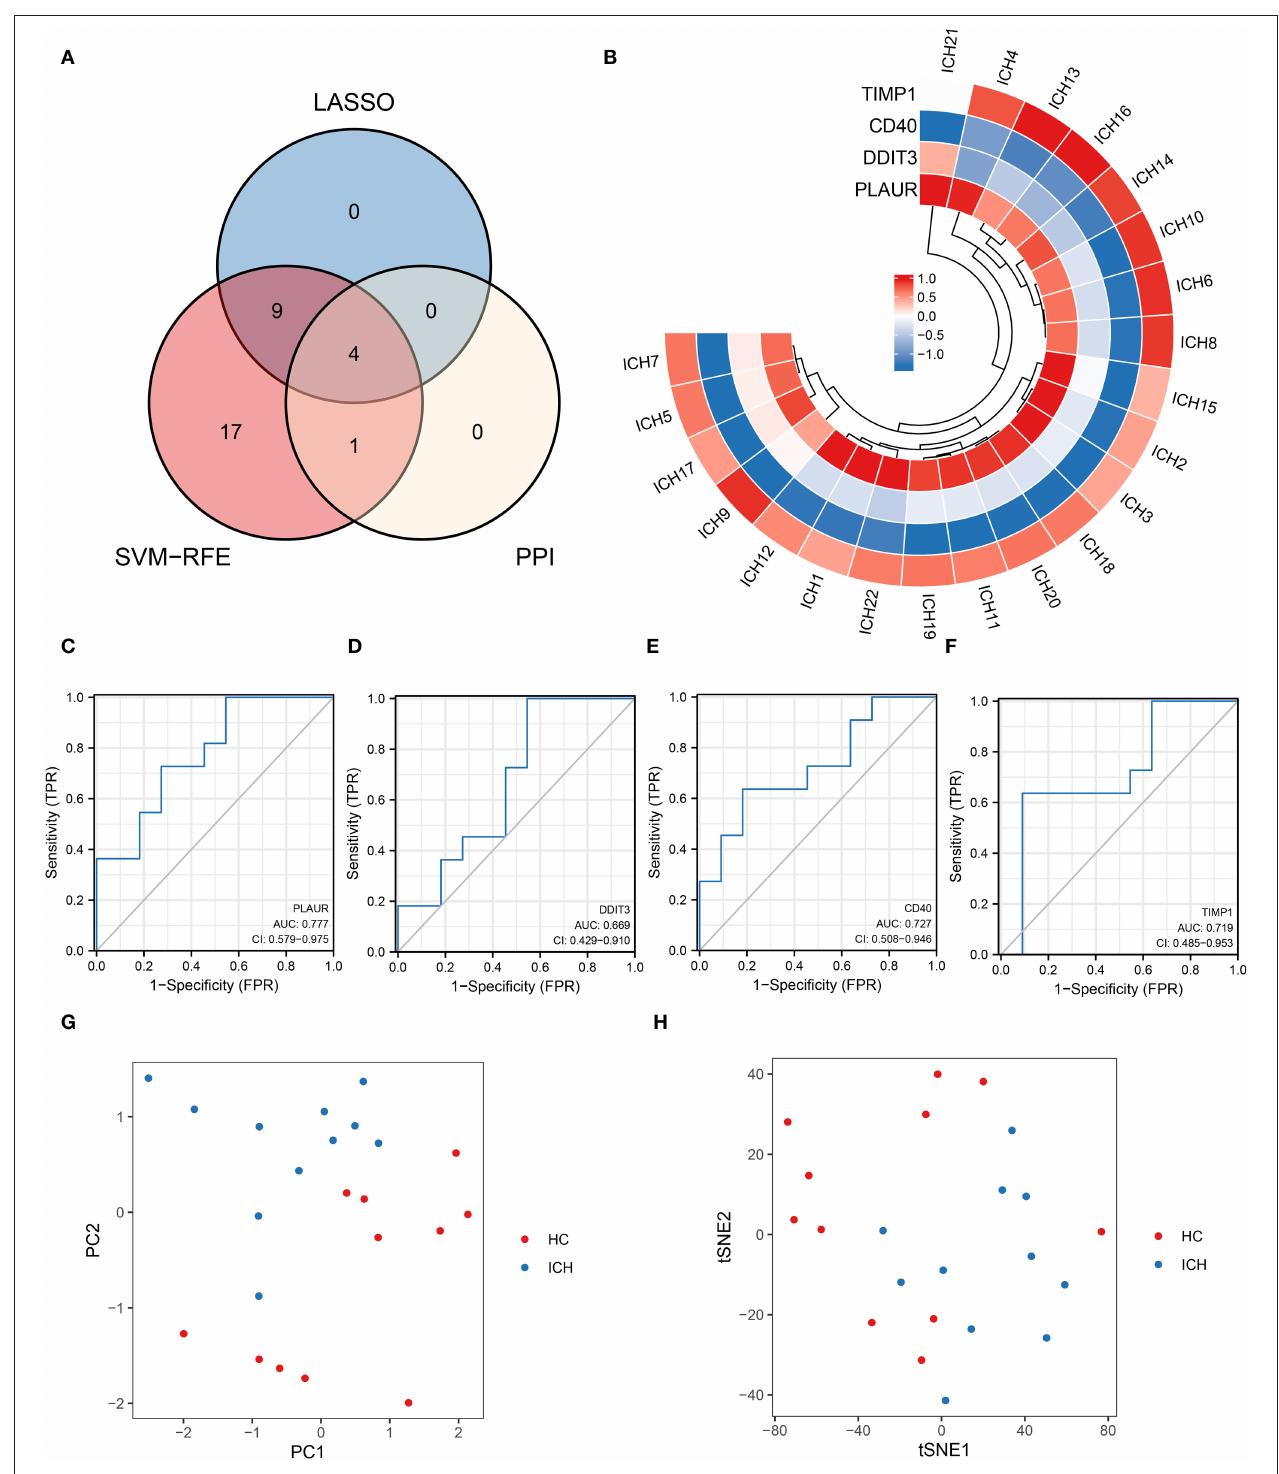
FIGURE 4 | Four key genes obtained from the cross-tabulation analysis. (A) The Venn diagram shows that four core genes are shared in the PPI network, SVM–RFE, and LASSO. (B) Relative expression profiles of these four core genes in all the patients. (C) PALUR, (D) DDIT3, (E) CD40, and (F) the ability of TIMP1 to differentiate between patients with ICH at different development stages. (G) PCA and (H) tSNE visualization showing the ability to discriminate between patients with ICH at different development stages.